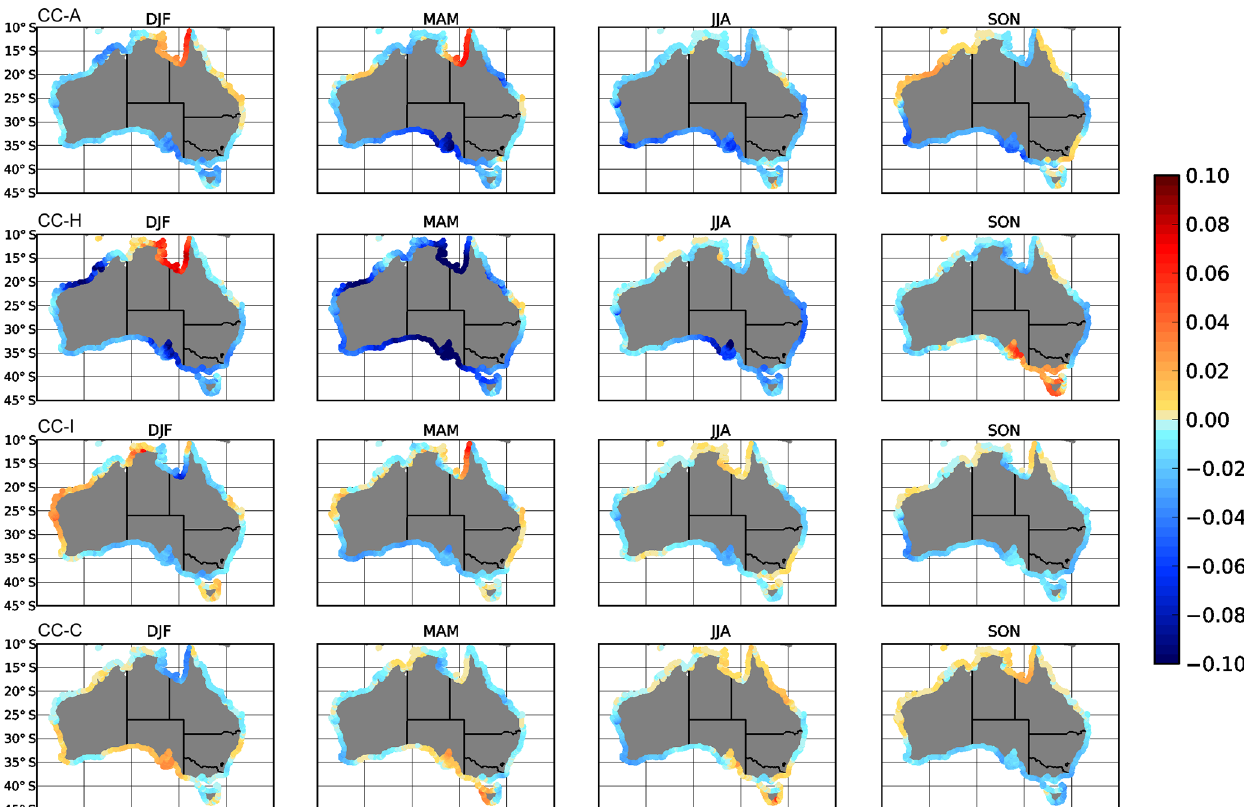
Figure 9. Difference in the average of the seasonal maximum sea level between 2081–2100 and 1981–1999 for the different CC models and seasons indicated. Units are in